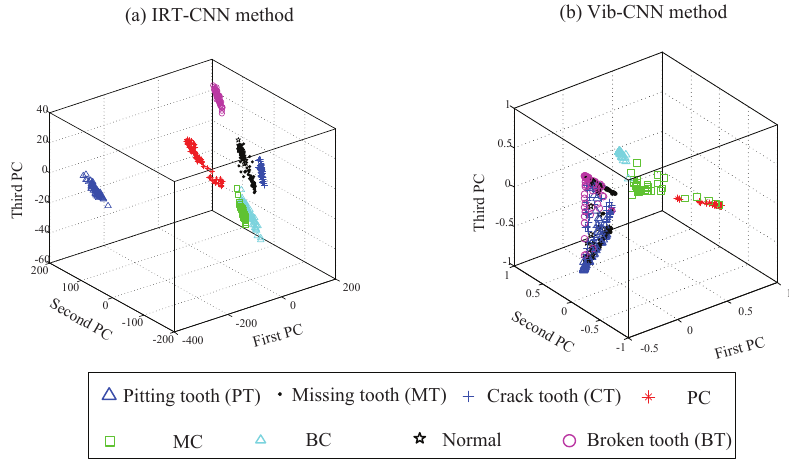
Figure 13. Projections of the features using PCA with different source signals: ( a ) IRT –CNN method ( b ) Vib-CNN method.